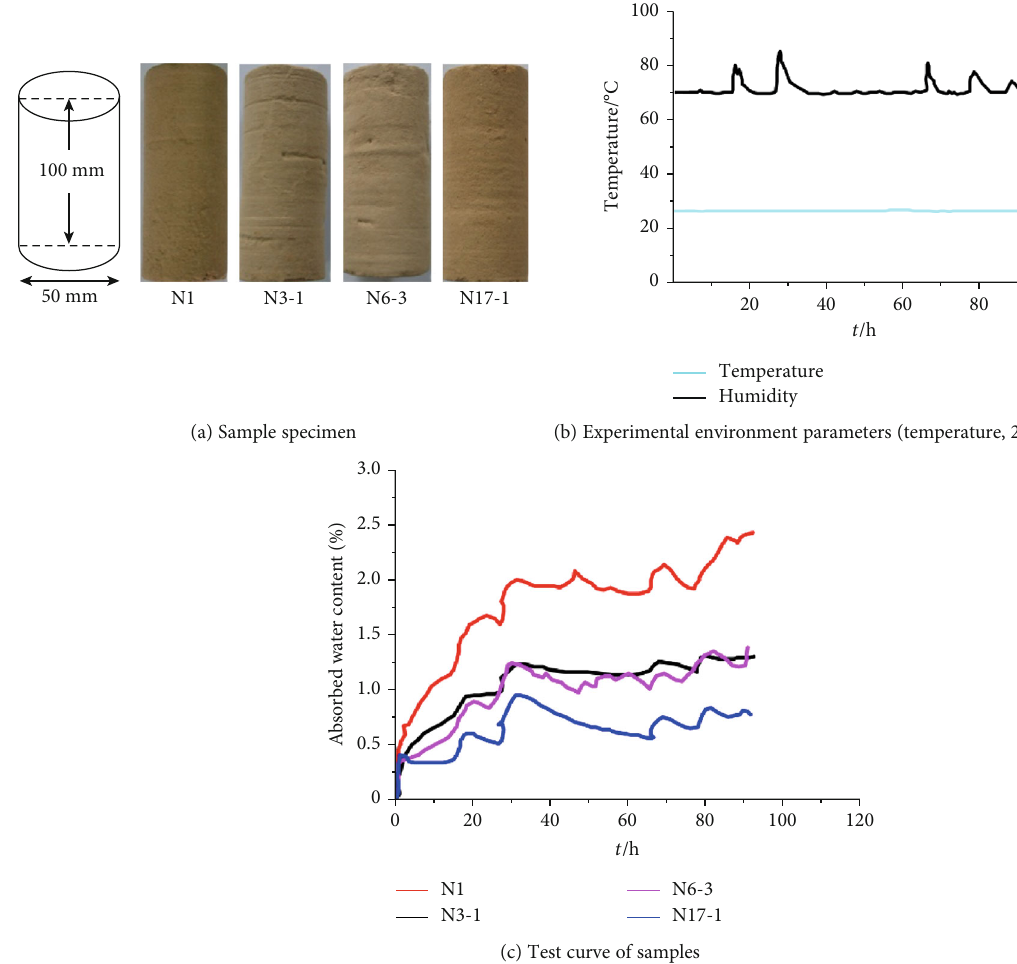
Figure 28: Gaseous water adsorption experiment of the mudstone samples from Mogao Grottoes in the summer in Group II